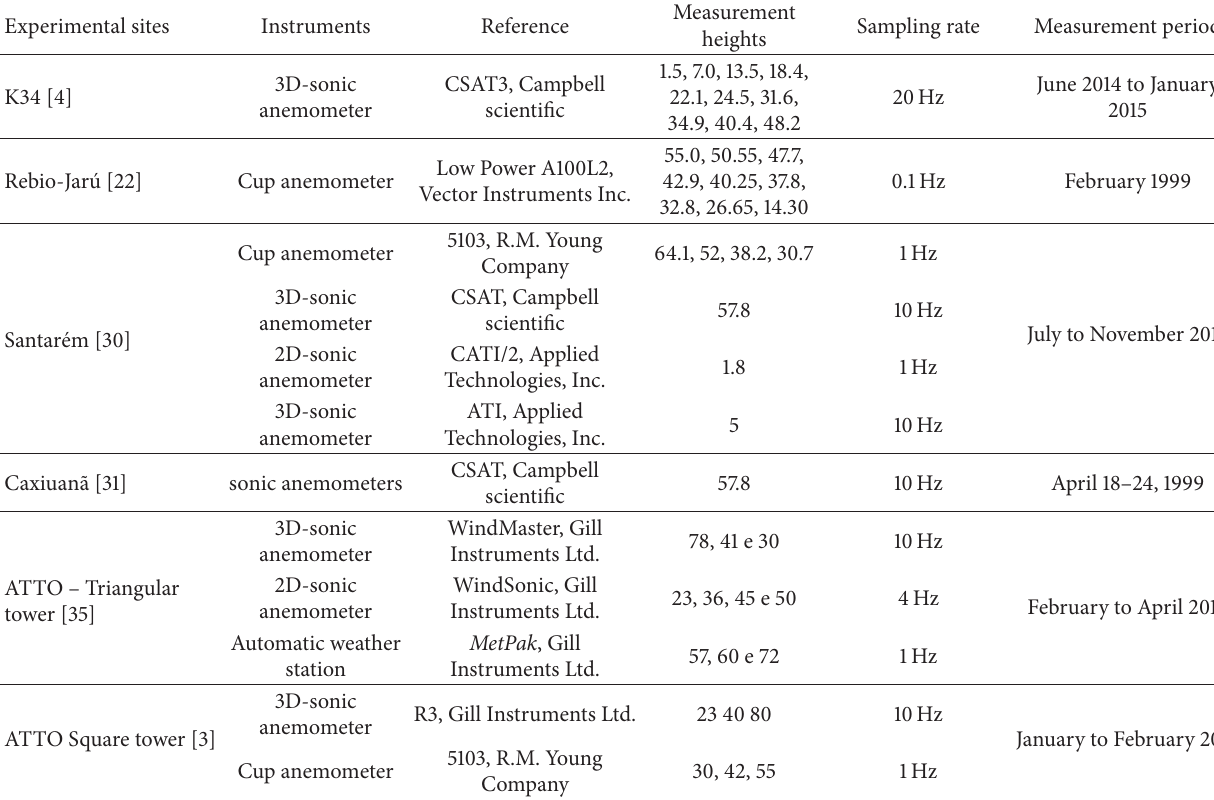
Table 1: Instruments and data periods